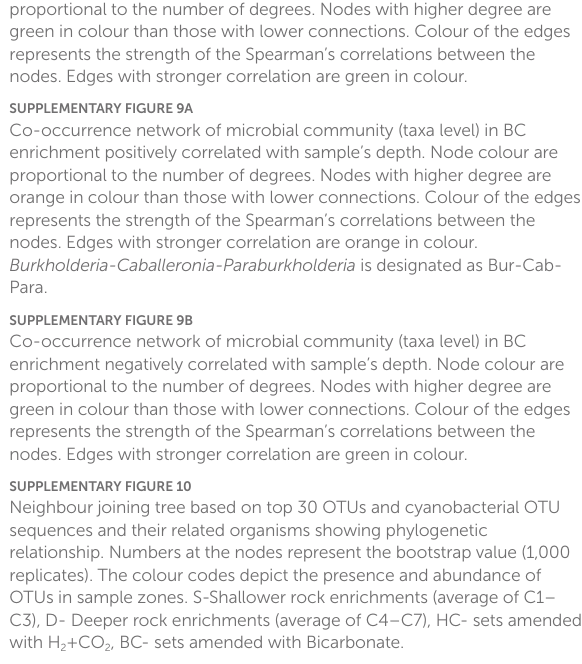
SUPPLEMENTARY FIGURE 3 Taxonomic distribution of the microbial communities in HC and BC enrichments at the phylum/class/order level.